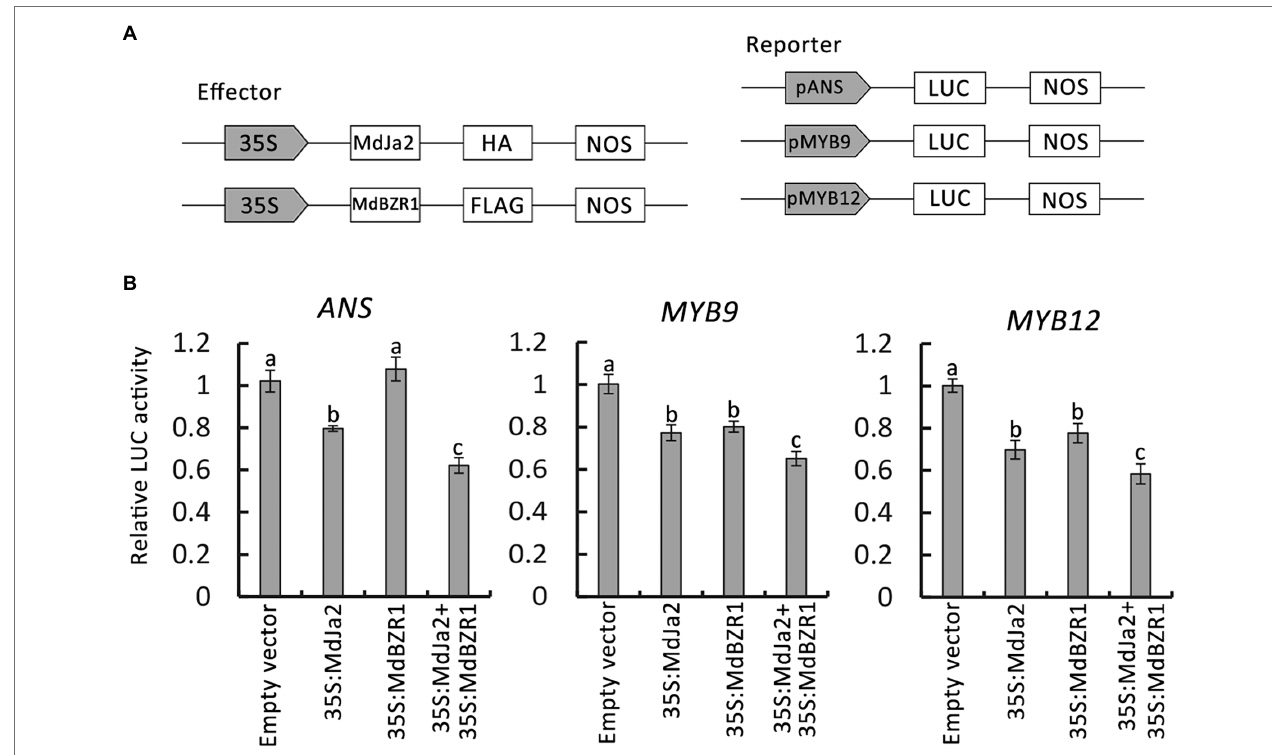
FIGURE 7 | Effects of the MdBZR1–MdJa2 interaction on downstream genes. (A) Schematic diagrams of the LUC reporter vectors containing the MdANS , MdMYB9 or MdMYB12 promoters and the effector vectors containing MdJa2 or MdBZR1 . (B) Effects of the interaction between MdJa2 and MdBZR1 on the